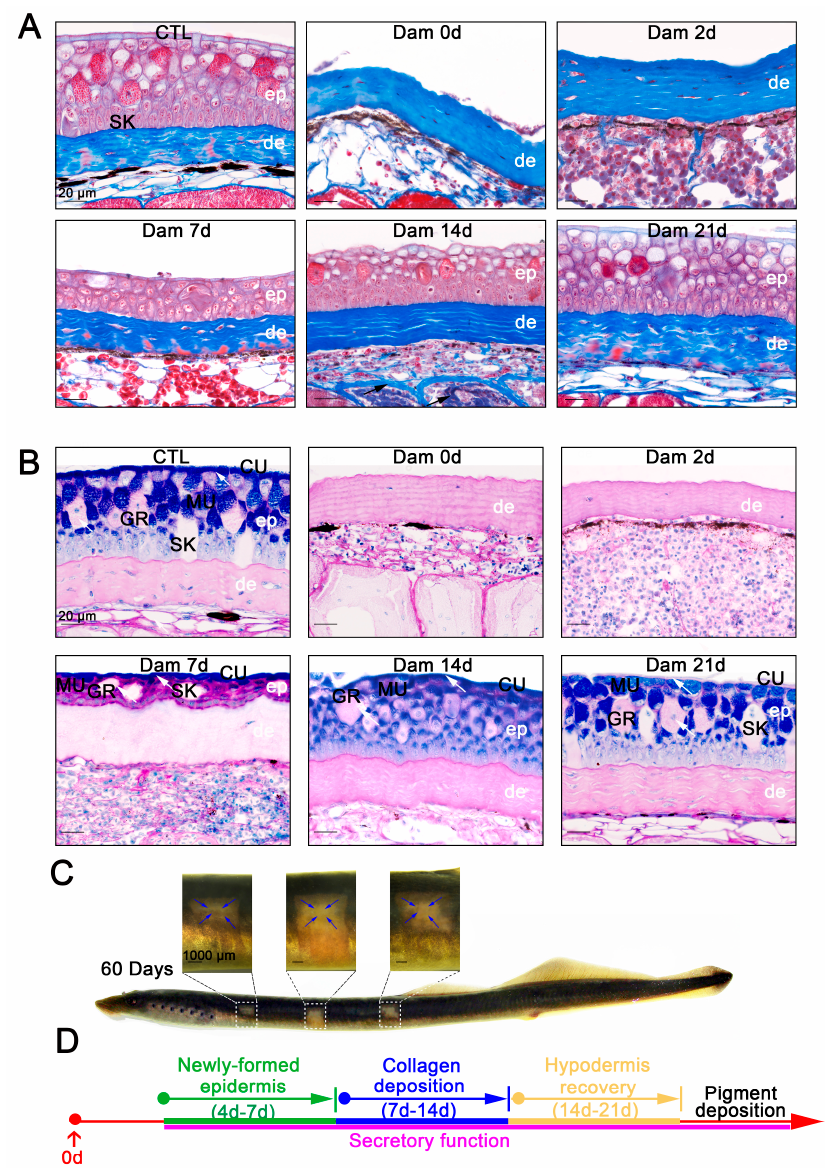
Figure 2. Histological staining results and long-term healing of skin damage in lampreys. ( A ) Mas- son’s trichrome staining results of skin tissue from the unwounded group until 21 days after dam- age. Scale bars, 20 μ m. ( B ) PAS-SB (Alcian blue-periodic acid Schiff staining) results for the undam- aged group until 21 days after damage; acidic mucus is stained blue, neutral mucus is stained red, mixed mucus is stained blue purple and the nucleus is stained light blue. The new epidermis has a secretory function (white arrow). Scale bars, 20 μ m. ( C ) Pigment deposition in the wounds of lam- prey 60 days after damage. Pigment deposits from the edge of the wound to the center. Scale bars,